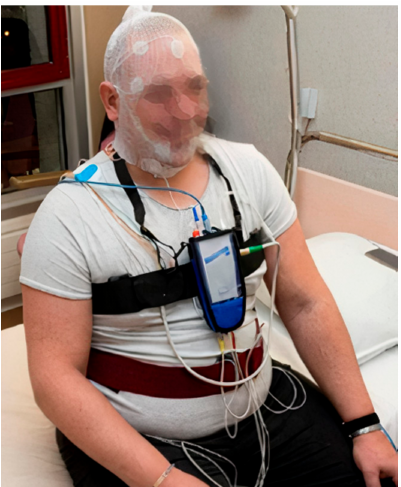
Figure 3. Subject instrumented before polysomnography (PSG) screening at the hospital.